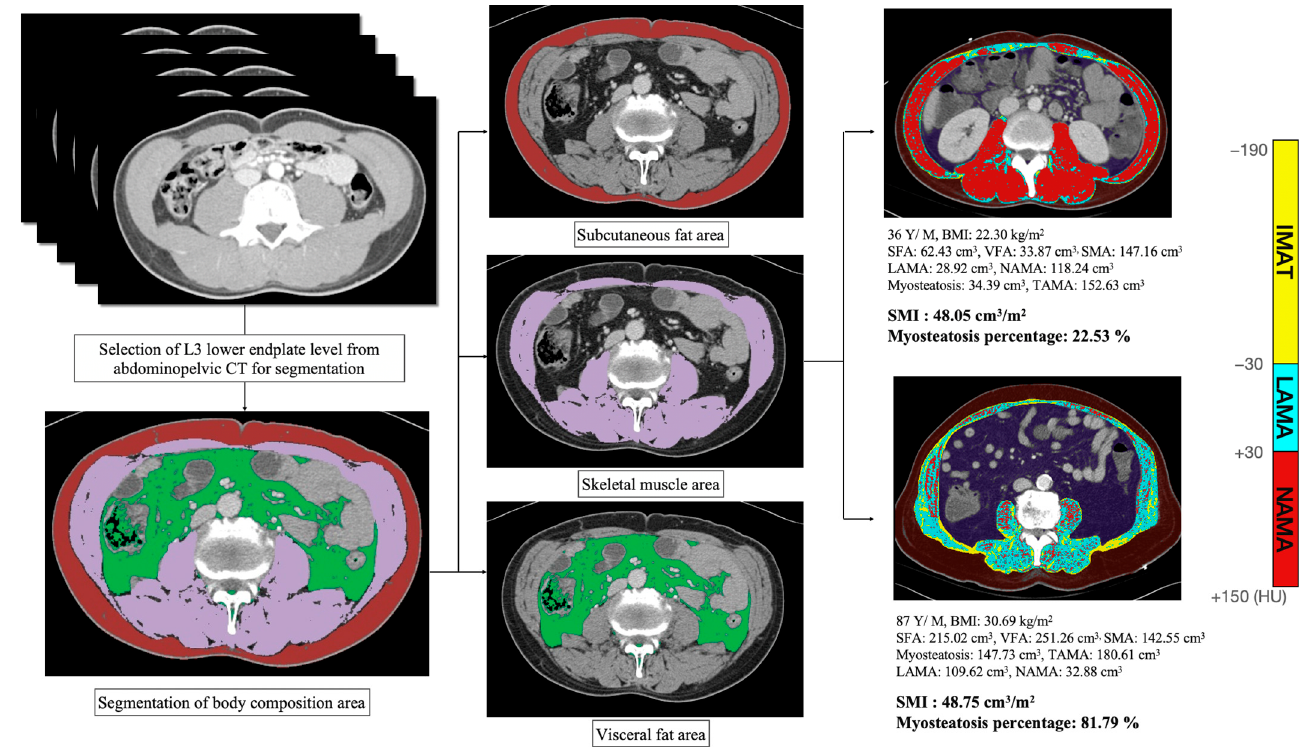
Figure 1. Example of body composition measurements. Muscle quality map generation using a web-based toolkit. After dividing body composition into 3 parts (i.e., subcutaneous fat, visceral fat, and skeletal muscle), skeletal muscle was classified in 3 areas according to certain attenuations (i.e., NAMA, LAMA, and IMAT). Myosteatosis area was defined as the sum of LAMA and IMAT. IMAT, inter/intramuscular adipose tissue area; LAMA, low-attenuation muscle area; NAMA, normal-attenuation muscle area; SMA, skeletal muscle area; TAMA, total abdominal muscle area.